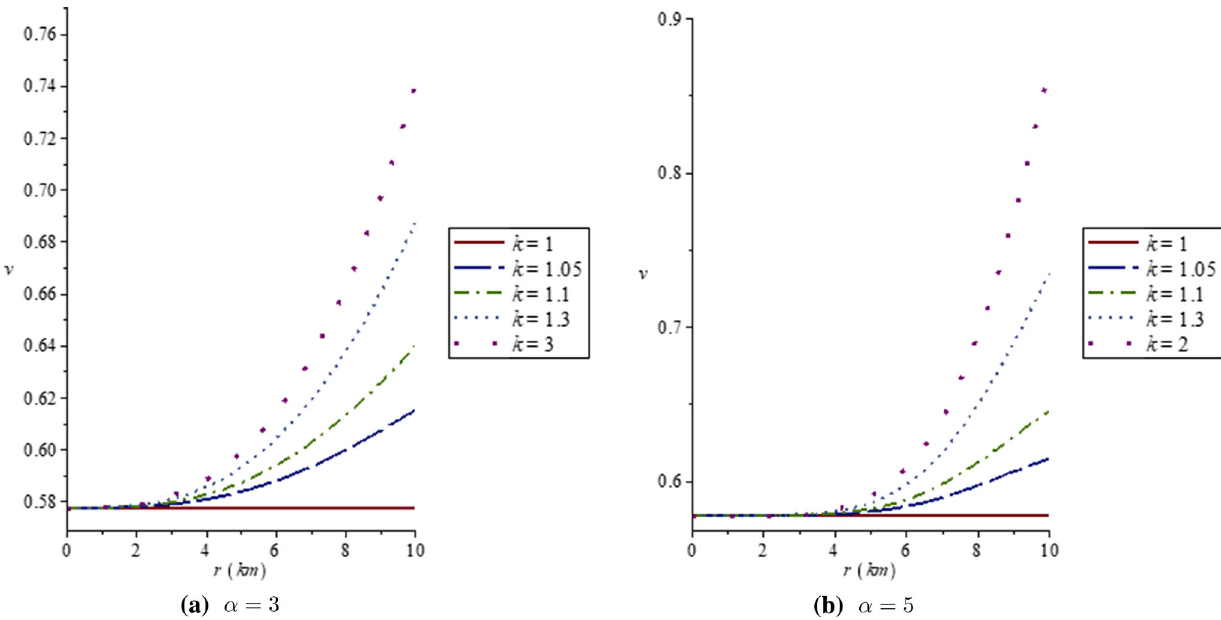
Fig. 6 Variation of the phase speed v = dp ( a ) and α = 5 ( b )